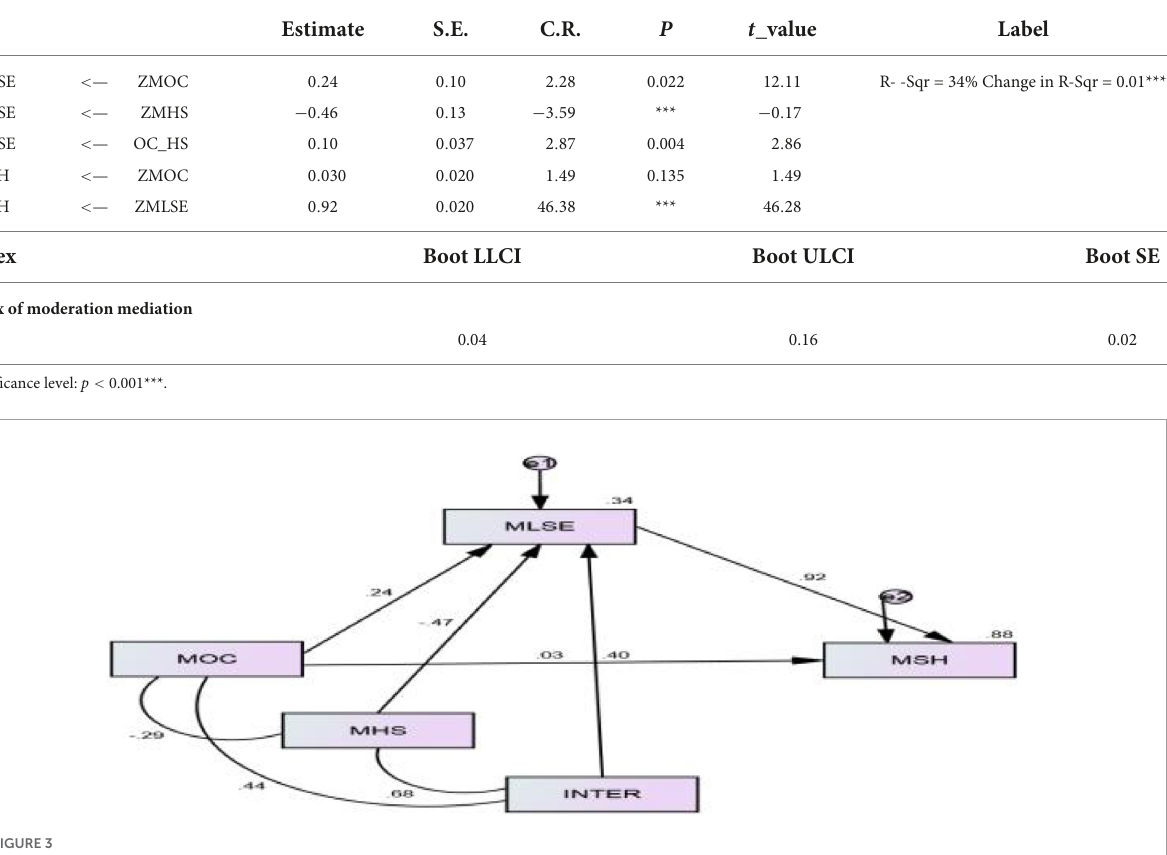
TABLE 4 Moderated mediation effect on sexual harassment.